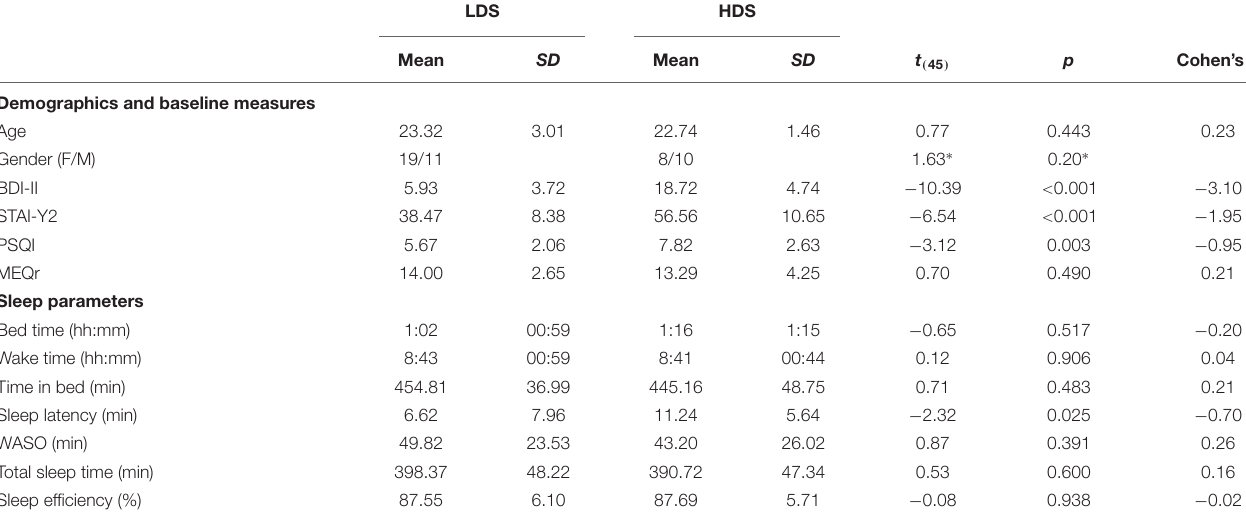
TABLE 1 | Demographics, psychological measures, and sleep parameters of the sample.